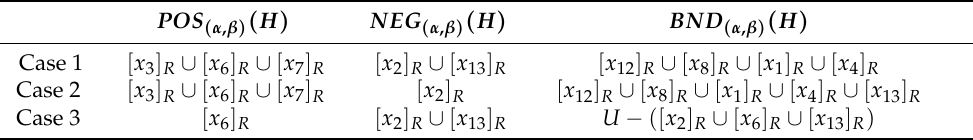
Table 8. The regions under different cases in the VPRS-HFEn